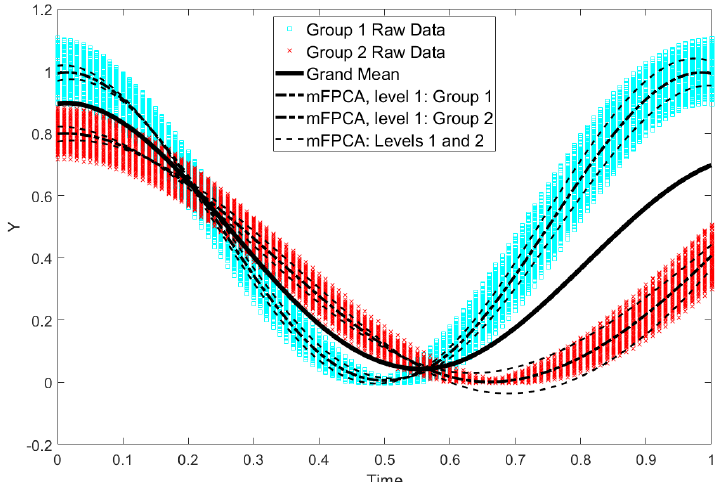
Figure 4. Data for the two groups in the test set of the Sine Wave dataset are shown by the green squares and red crosses (1000 trajectories per group). The overall “grand mean” is shown also. Model fits of mPCA (first mode at level 1 only denoted “mPCA, Level 1: Group 1/2”) based on the centroids in Figure 3 are shown also. Within-group (level 2) variation is added to the model fit for mPCA for each group (i.e., ± 1.96 × √𝜃 1 2 × 𝜓 1 2 , denoted “mPCA: Levels 1 and 2”).